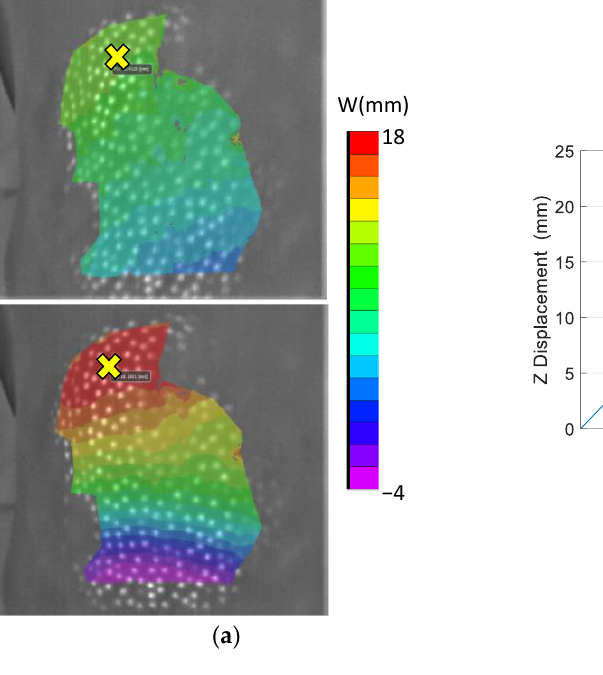
Figure 7. Abdominal area test. ( a ) Digitalization at two different moments. ( b ) Displacement of the point marked with yellow cross.